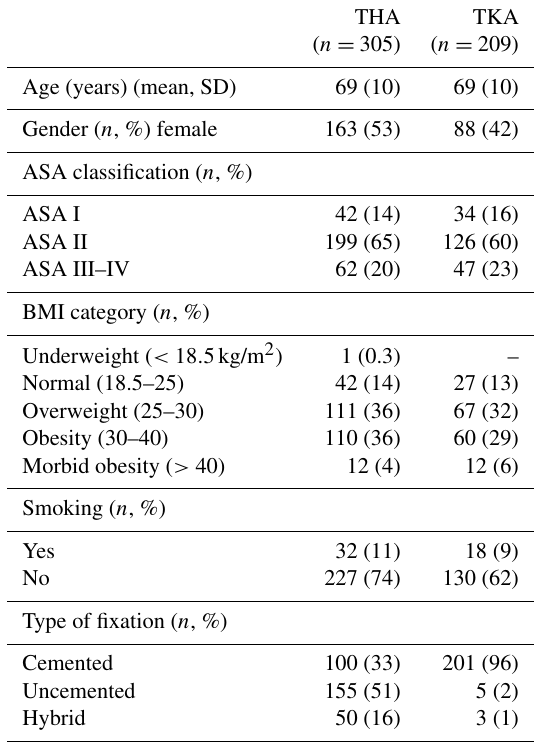
Figure 1. Patient flow. Table 1. Patient characteristics of the study population during the primary procedure ( n = 514).